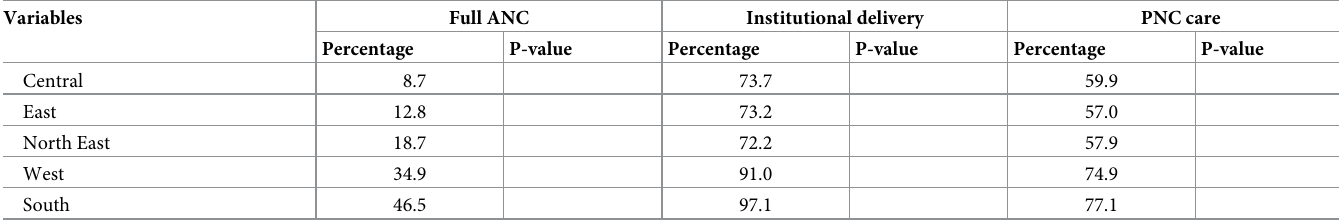
education, exposure to mass media, wealth index, and geographical region. Results from Table 3 indicate that women’s autonomy is a significant predictor of maternity care in India as the odds of maternal healthcare increased with increasing the level of autonomy. Crude analy- sis reveals that women who had high decision-making autonomy were more likely to receive full ANC during pregnancy (UOR: 1.57, 95% CI: 1.45–1.71), institutional delivery (UOR: 1.12, 95% CI:1.04–1.21), and PNC within 48 hours of delivery (UOR: 1.40, 95% CI: 1.31–1.49)